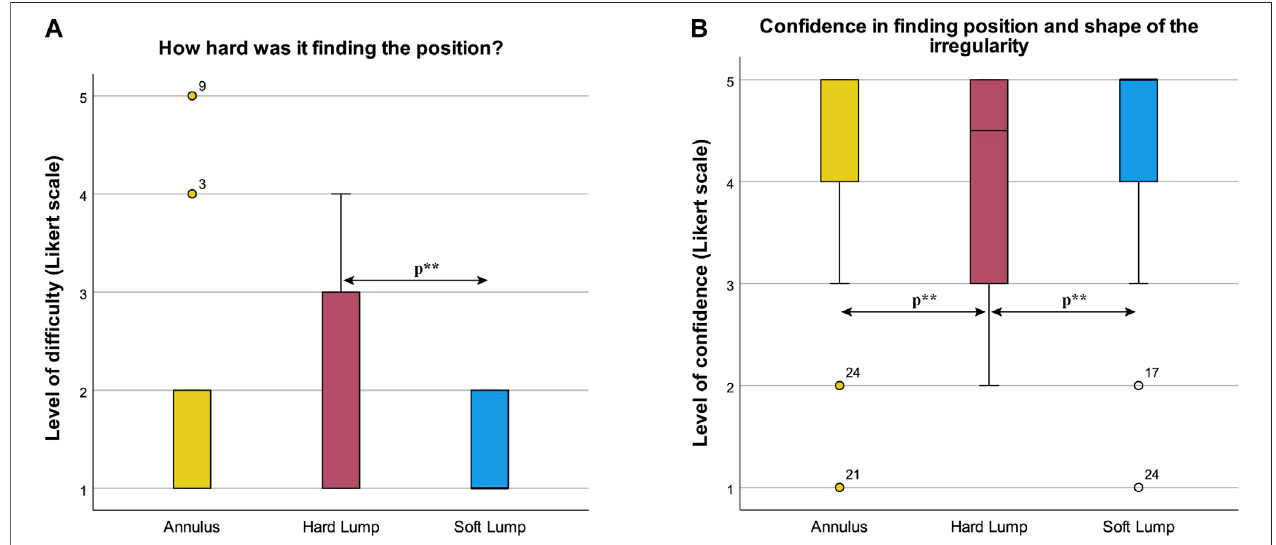
FIGURE 14 | Box plot of results from the questionnaire (A) How hard was it fi nding the position, and (B) Self-assessment of con fi dence in the accuracy of their drawing.